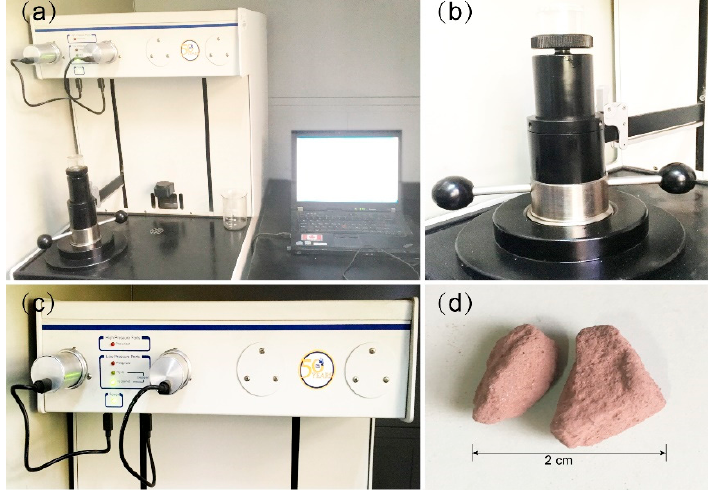
Figure 5. The AutoPore IV and sample. ( a ) Mercury intrusion porosimetry; ( b ) the high-pressure test pipeline; ( c ) the low-pressure test pipeline; ( d ) the sample.